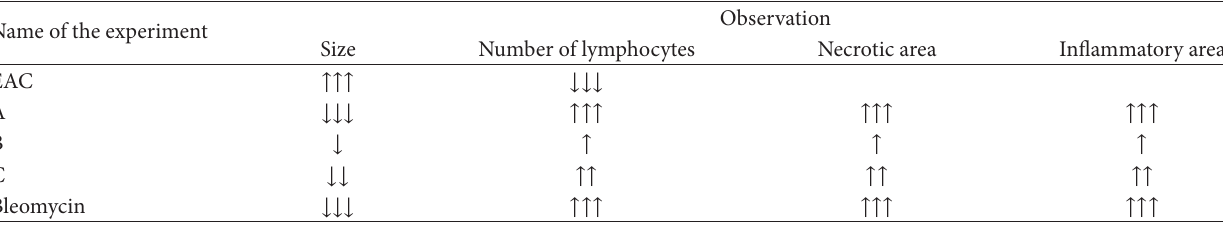
Table 11: Histopathological effect of test compounds.